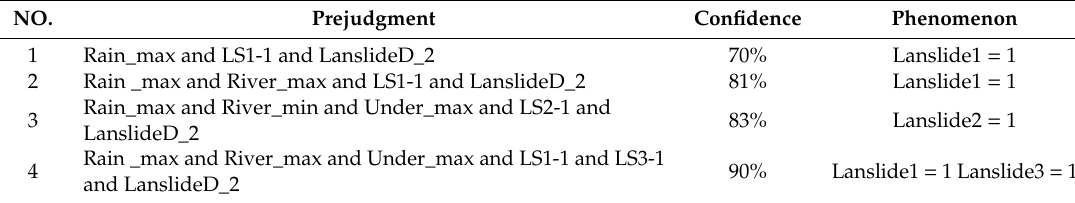
Table 4. Pre-judgment results by FP-Growth.